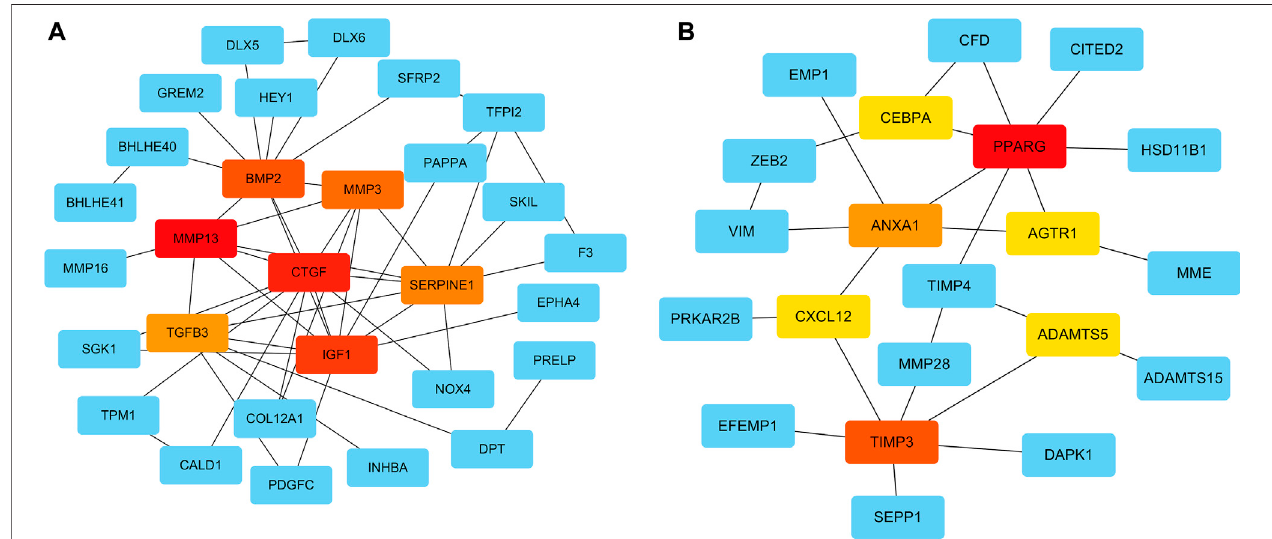
FIGURE 4 | Protein – protein interaction (PPI) networks of the upregulated and downregulated genes were constructed using Cytoscape software. The top seven upregulated (A) and downregulated (B) hub genes, according to the MCC, MNC, and Degree modules of the cytoHubba were identi fi ed.